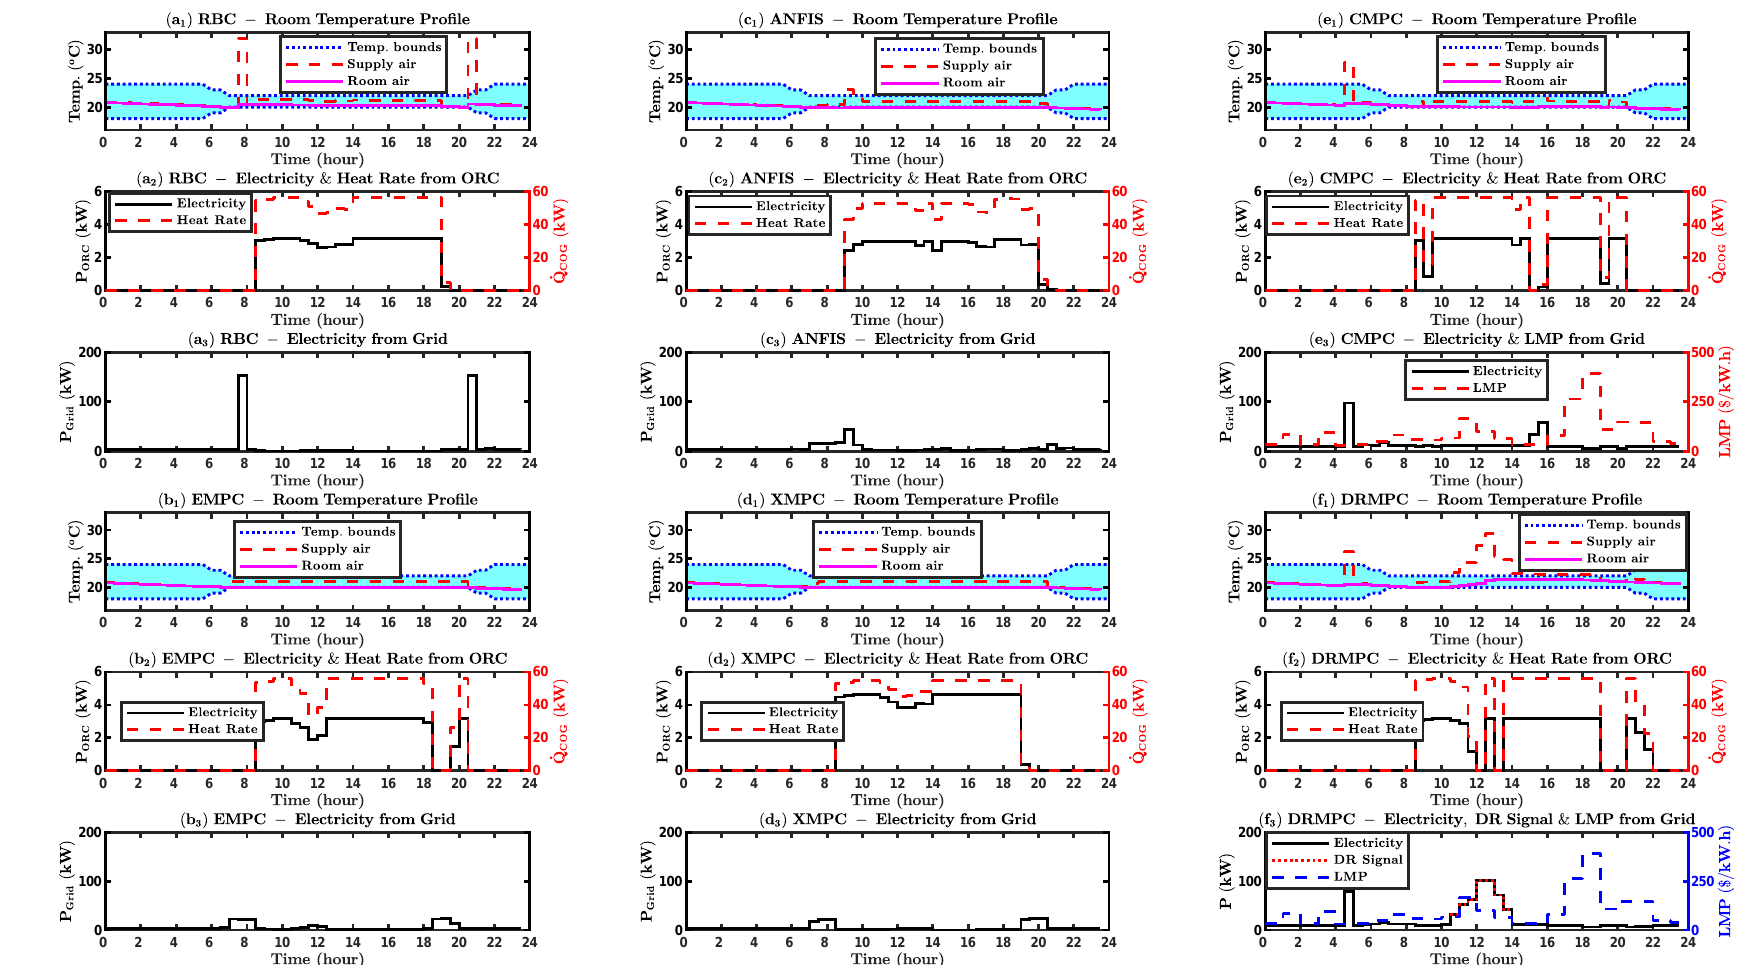
Figure 20. Control results of the different control frameworks for a winter day shown in Figure 19. (Adapted from